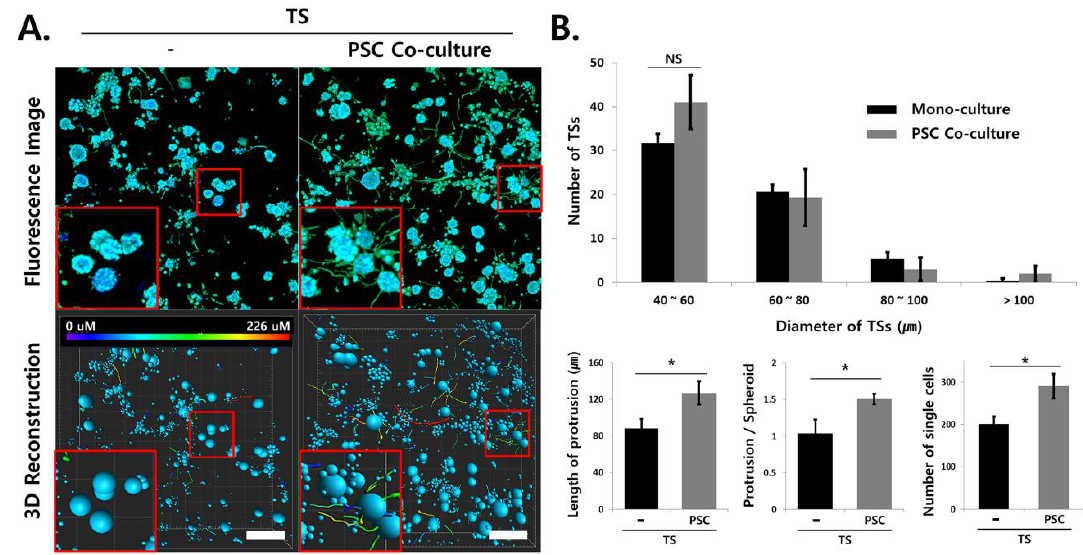
Figure 7. Analysis of single-cell dissemination and plasma membrane protrusion. ( A ) Invasive protrusions from tumor spheroids (TSs) and single-cell dissemination were analyzed in three dimensional-reconstructed images of the whole microtumor. Insert: representative images of individual TSs. Membrane protrusion was traced by immunostaining of vimentin. Protrusions with varying lengths are shown using spectral colors. ( B ) Image analysis was performed by ImageJ (number and size of spheroids) and Imaris (protrusion and single cell dissemination). PANC-1 TSs were cultured with or without pancreatic stellate cell for 6 days. Scale bars: 100 µ m. * p < 0.05. NS; Non-significant, TS; tumor spheroid, PSC; pancreatic stellate